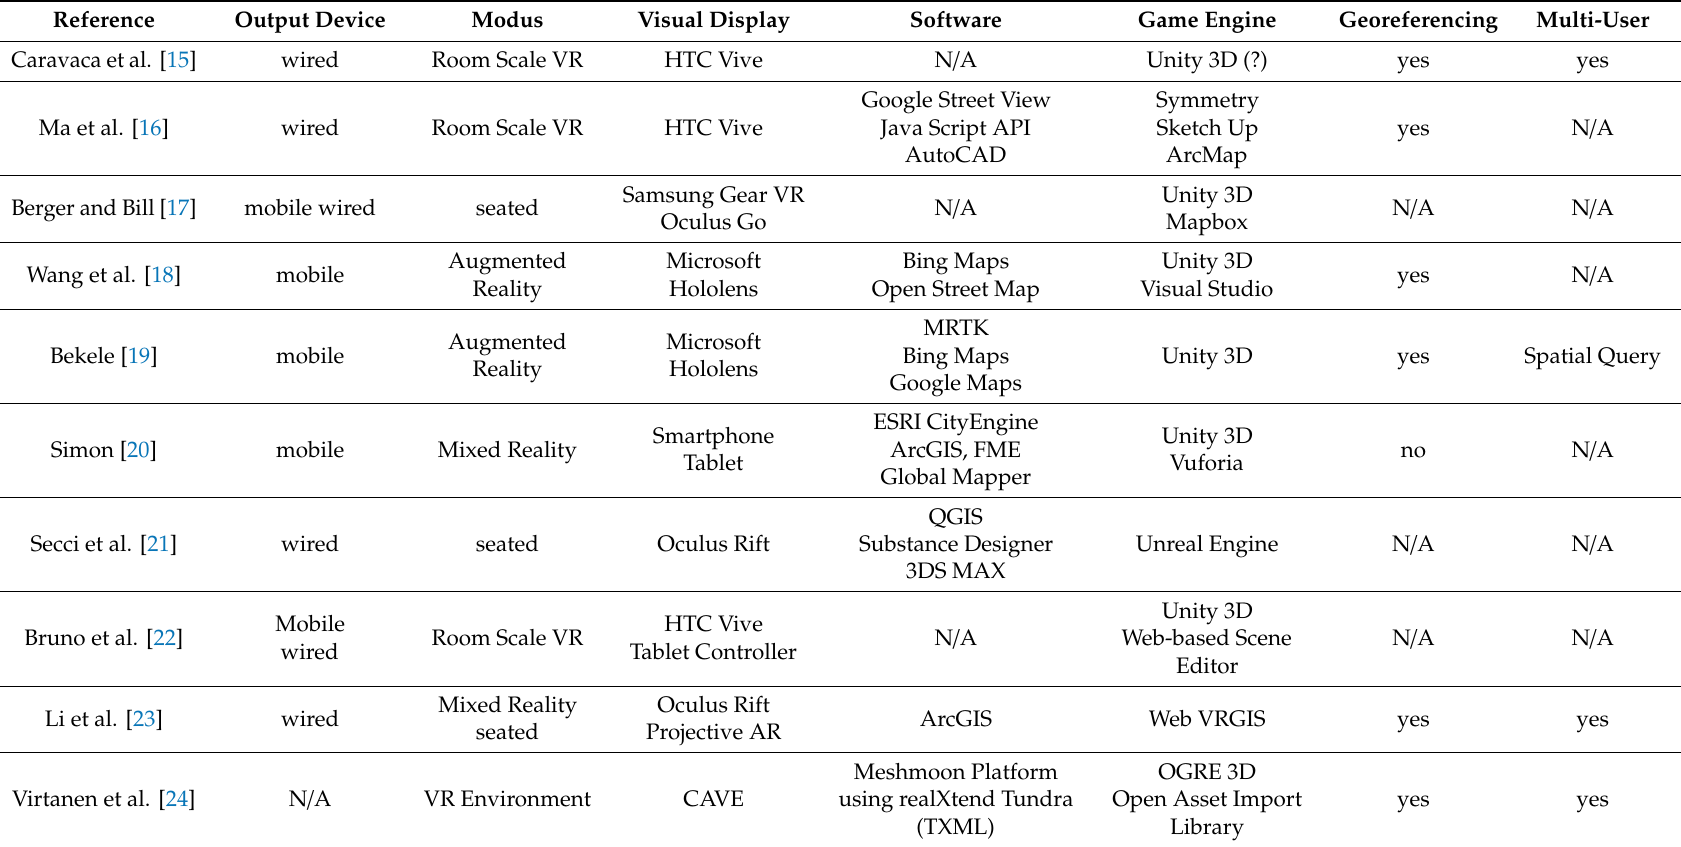
Table A1. Interactive